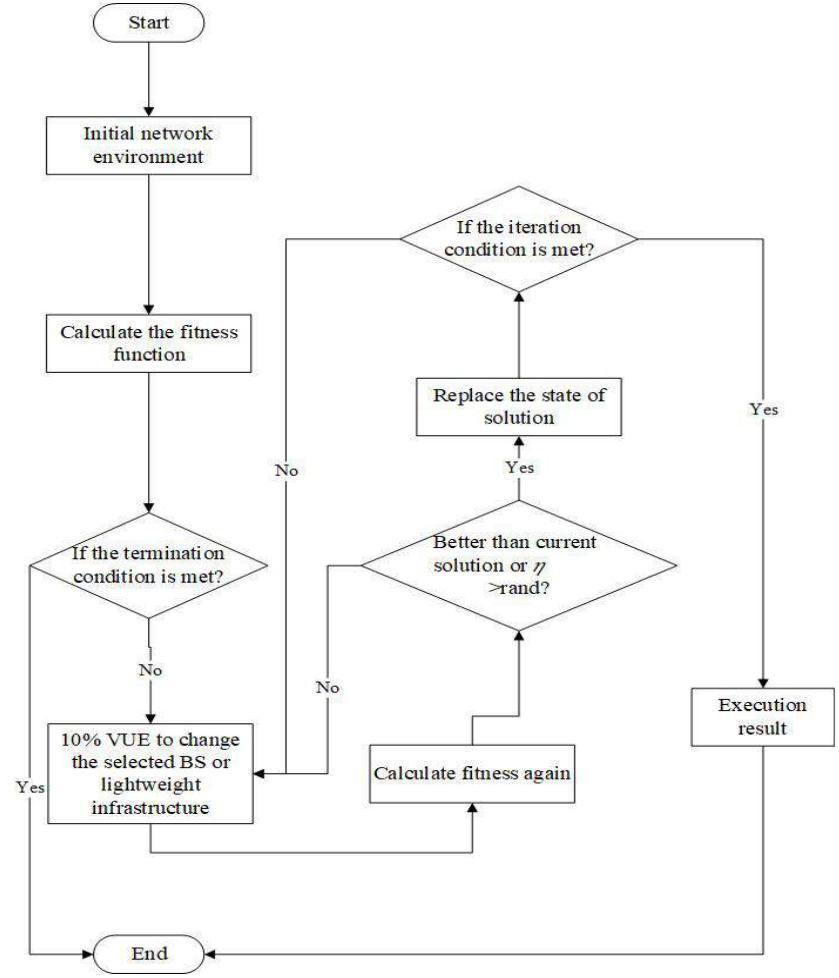
Figure 5. The flowchart of SA